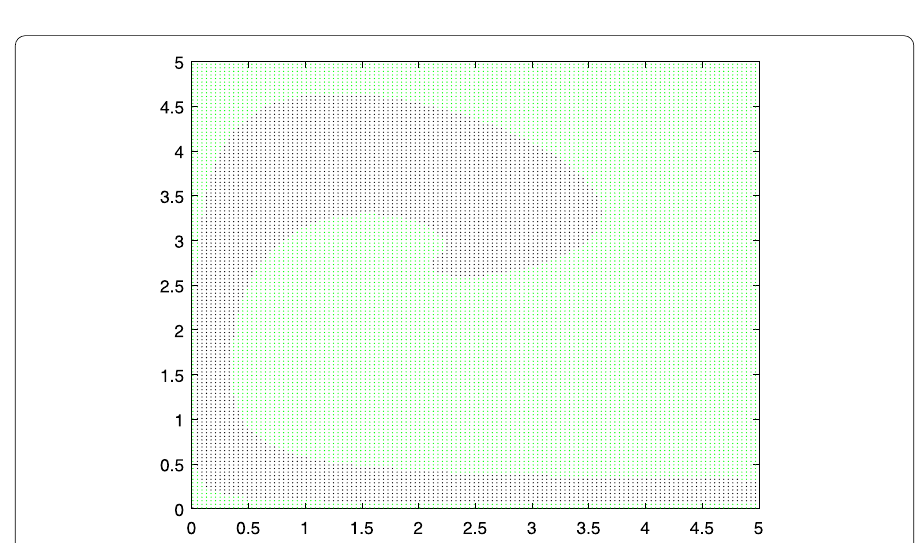
Figure 3 Basin of attraction of the two attractors of model (17) with the parameters are identical to those in Fig. 1. The blue and green points are attracted to the attractors shown in Fig. 2 from top to bottom,